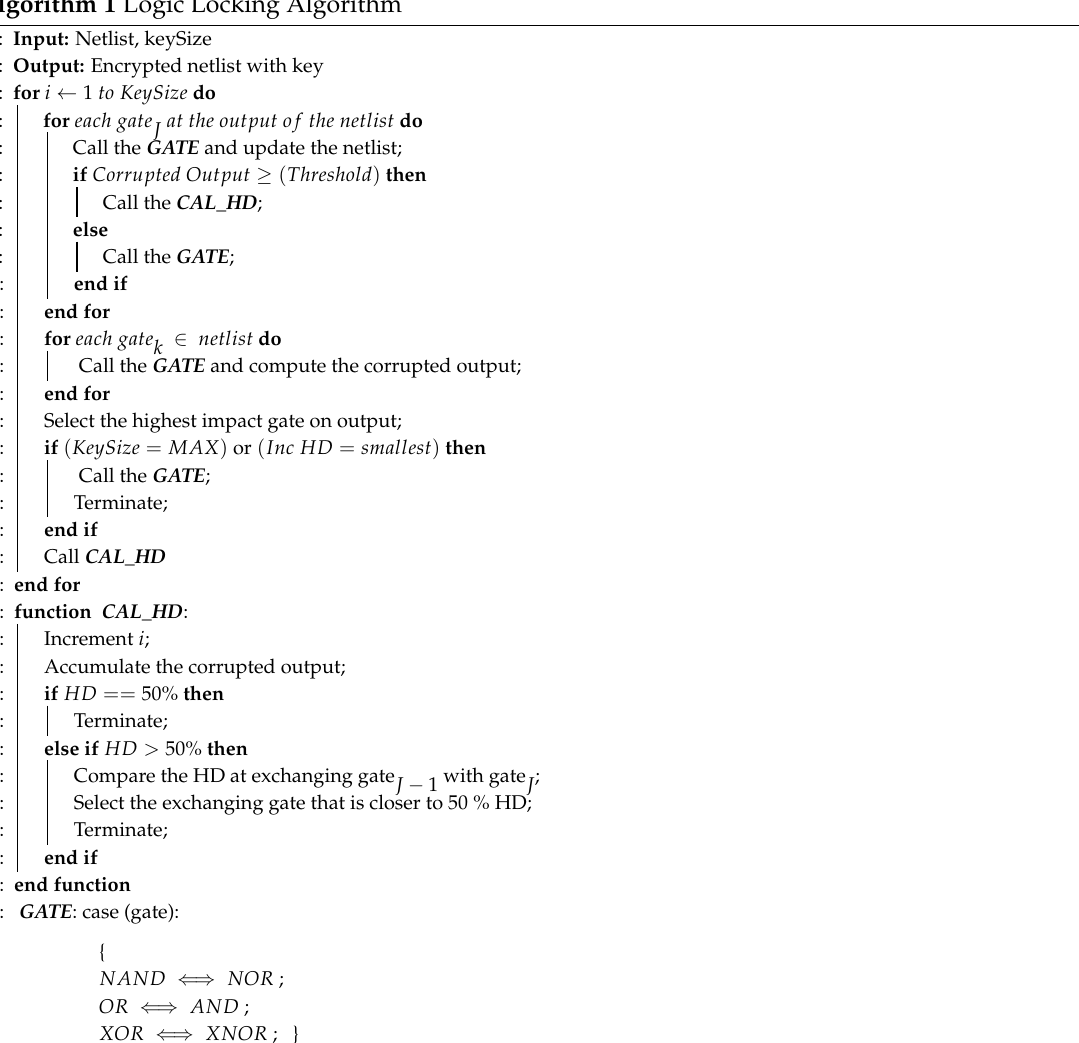
Algorithm 1 Logic Locking